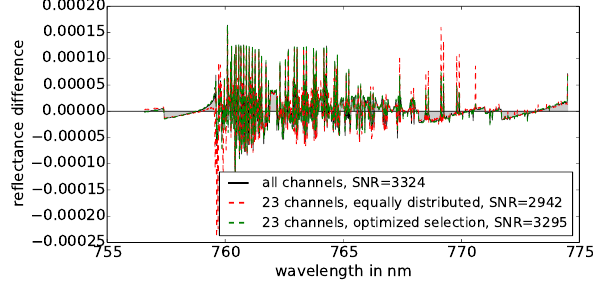
Fig. 10. Residuals between original and reconstructed spectra. The black line with the grey shaded area shows the residual between the original spectra and the one reconstructed using the full spectral information and 15 principal components. The red line shows the residual using only 9 spectral bands, which were selected using the equal sampling technique. The green line shows similar results, but the optimization of C matrix residuals was used to select the spectral sample.